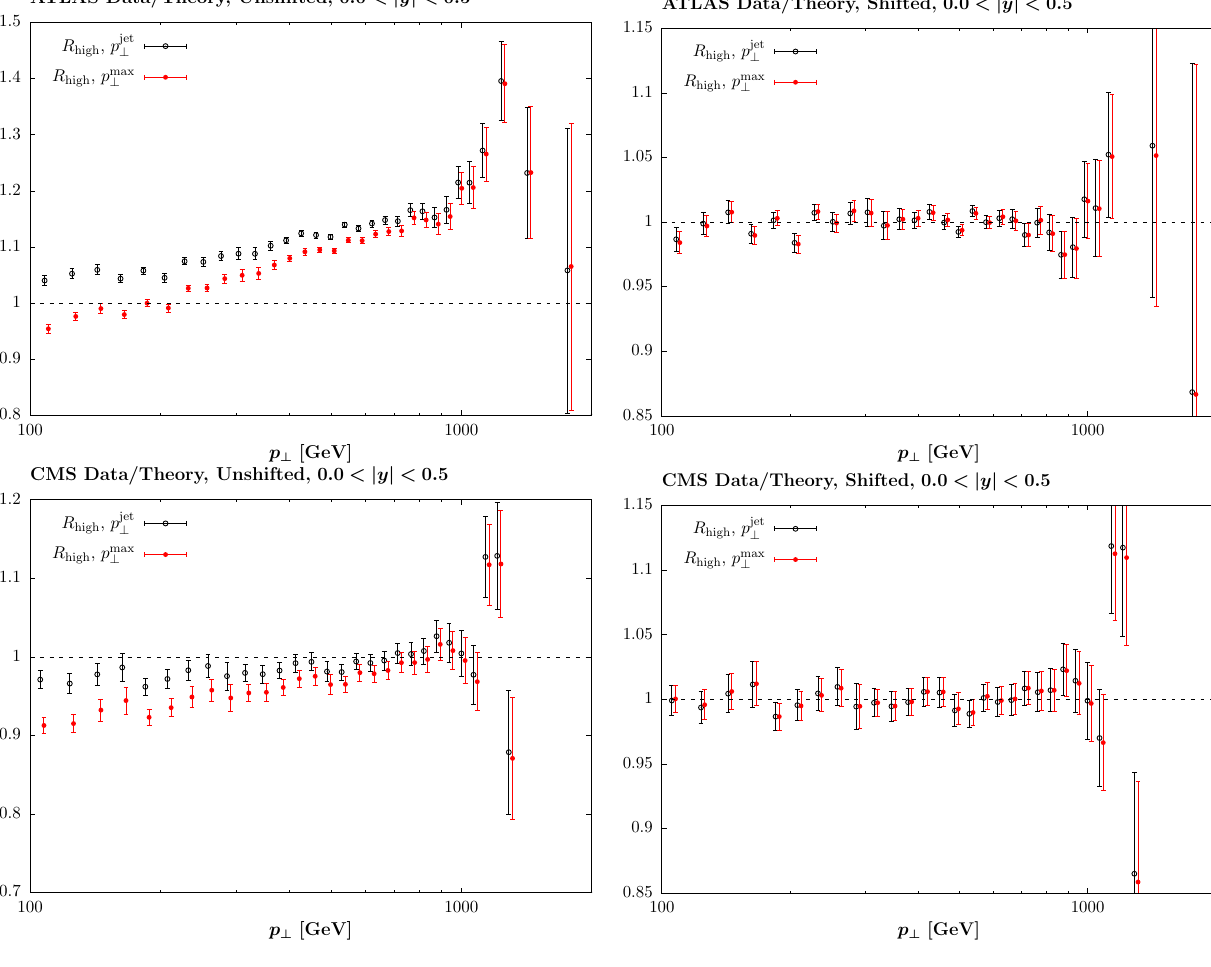
Fig. 9 As in Fig. 8, but with the higher R radius